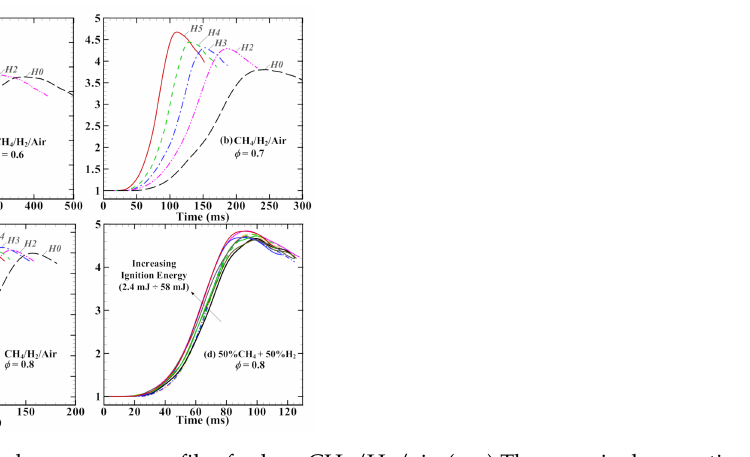
Figure 5. In-chamber pressure profiles for lean CH 4 /H 2 /air. ( a – c ) Three equivalence ratios φ = 0.6, 0.7, 0.8 with different H 2 fractions of 0 ∼ 50% (indicated by H0 to H5); ( d ) 50% CH 4 /50% H 2 at φ = 0.8 by varying the ignition energies E ig = (2.4 ∼ 58) mJ.